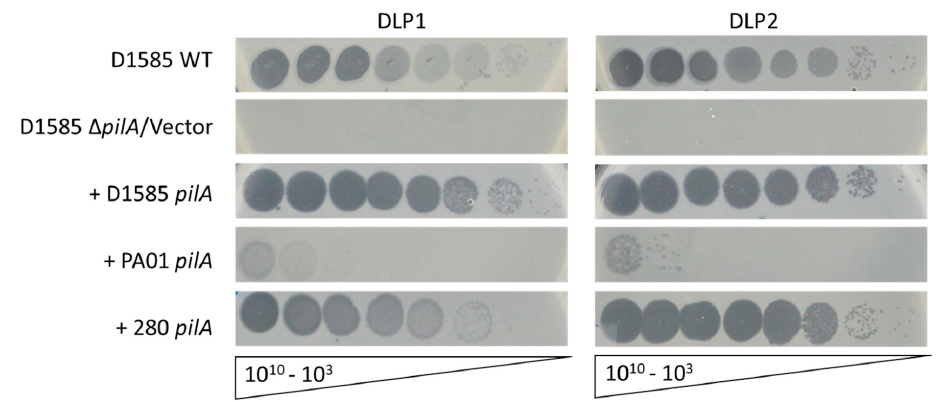
Figure 4. Infection of S. maltophilia D1585 expressing varying pilin subunits by DLP1 and DLP2. D1585